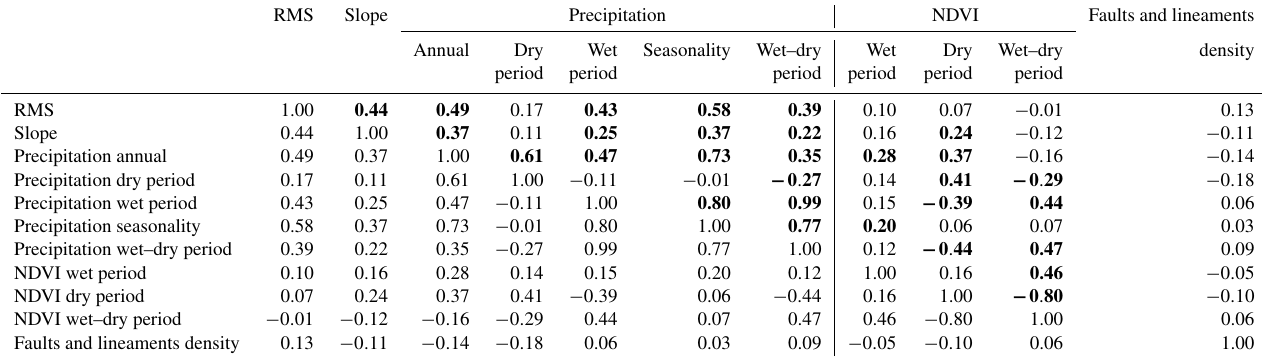
Table 1. Correlation matrix of the selected factors controlling distribution of geohazards in the MER area. The number of samples is 153, and the critical value for correlation coefficient ( R ) at the 95% significance level is 0.195. A statistically significant (95%) R is in bold. RMS Slope Precipitation NDVI Faults and lineaments Annual Dry Wet Seasonality Wet–dry Wet Dry Wet–dry density period period period period period period